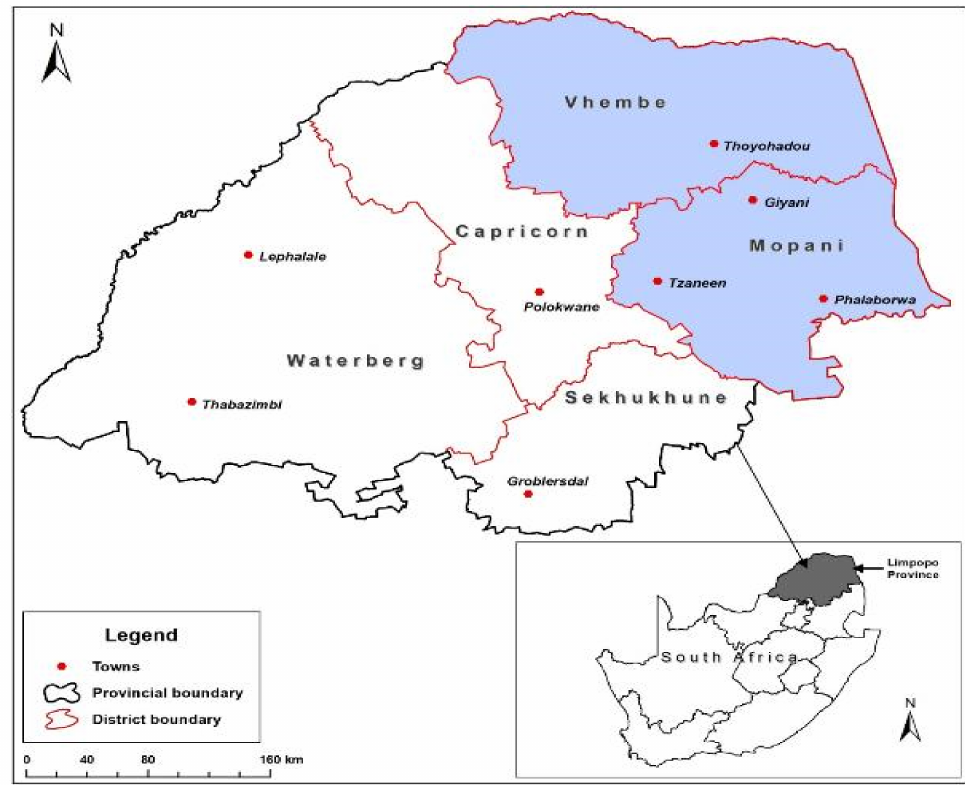
Figure 1. The Mopani and Vhembe Districts in the Limpopo